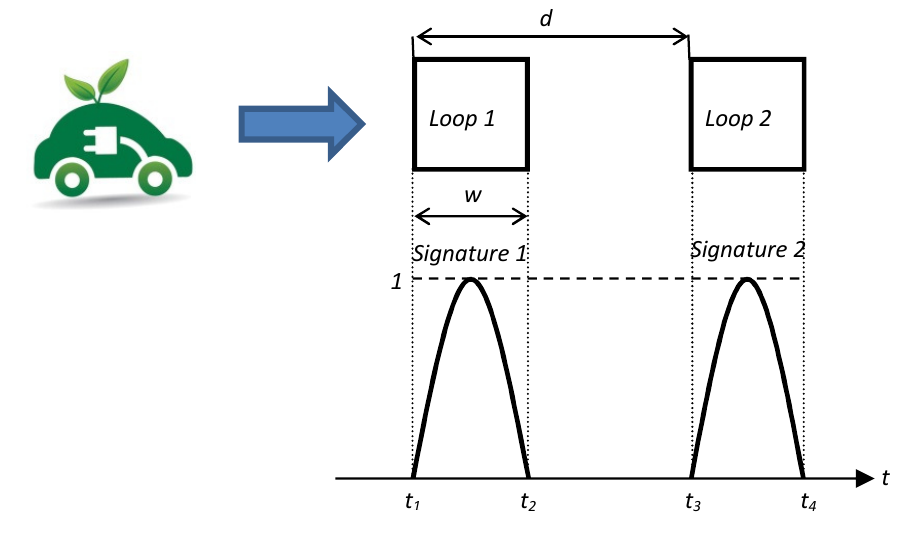
Figure 19. Scheme for time measurements.